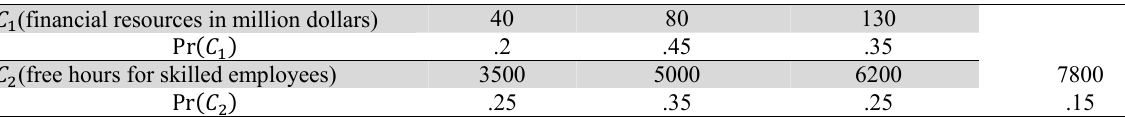
Discrete distribution of available resources